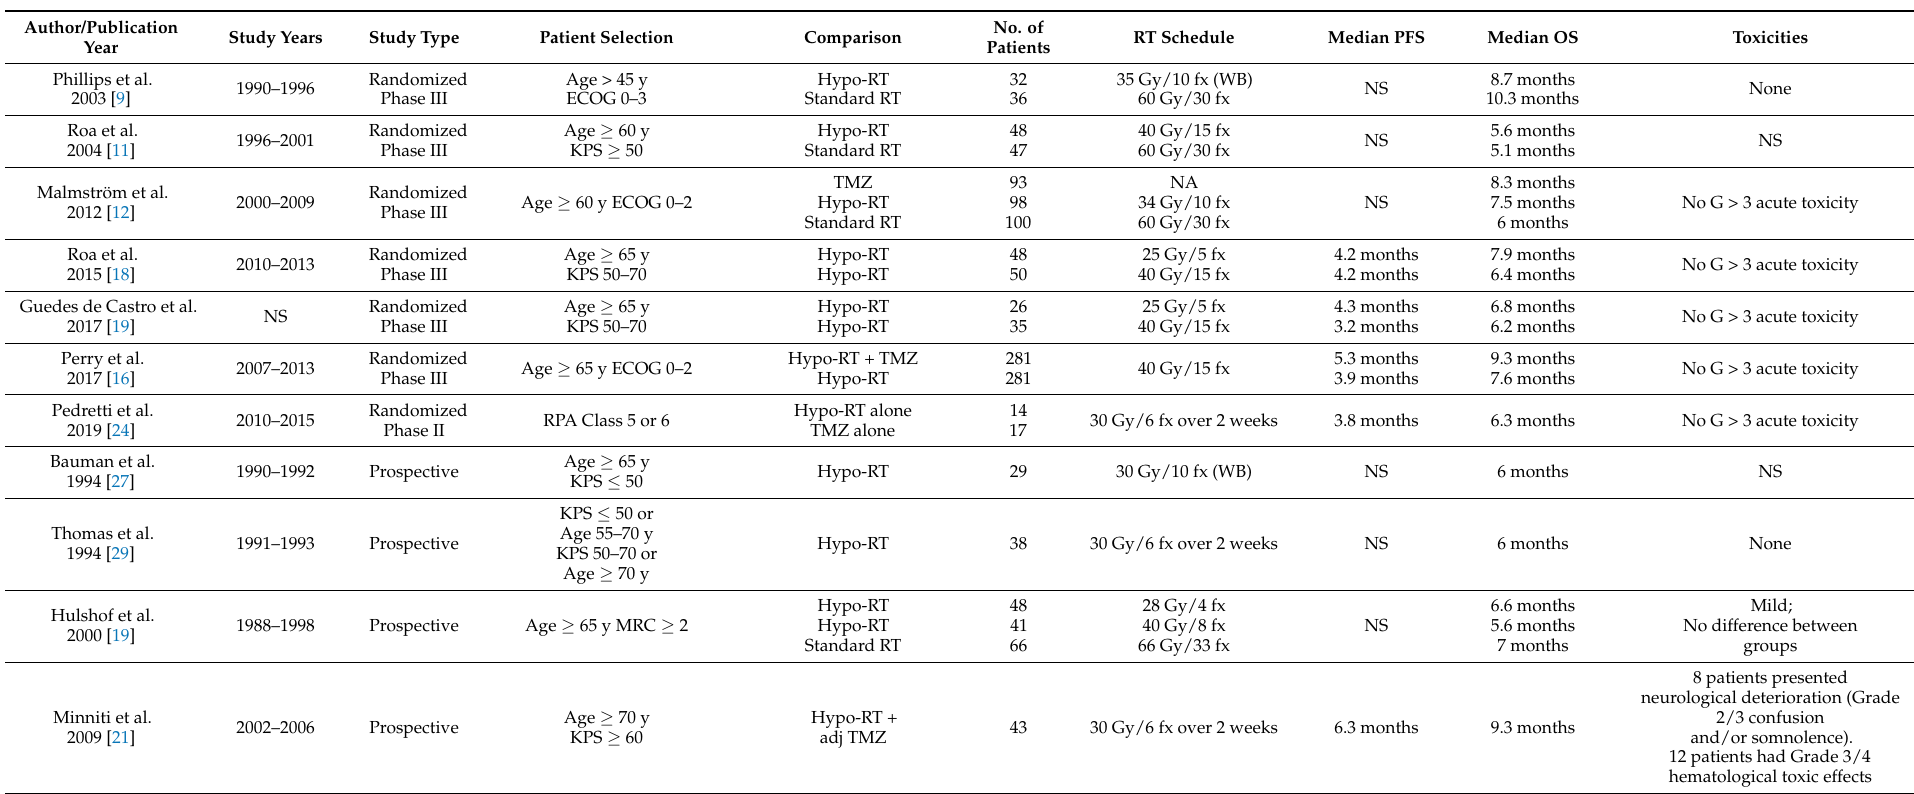
Table 4. Literature review of studies regarding elderly/frail patients with high-grade gliomas and treated with hypofractionated